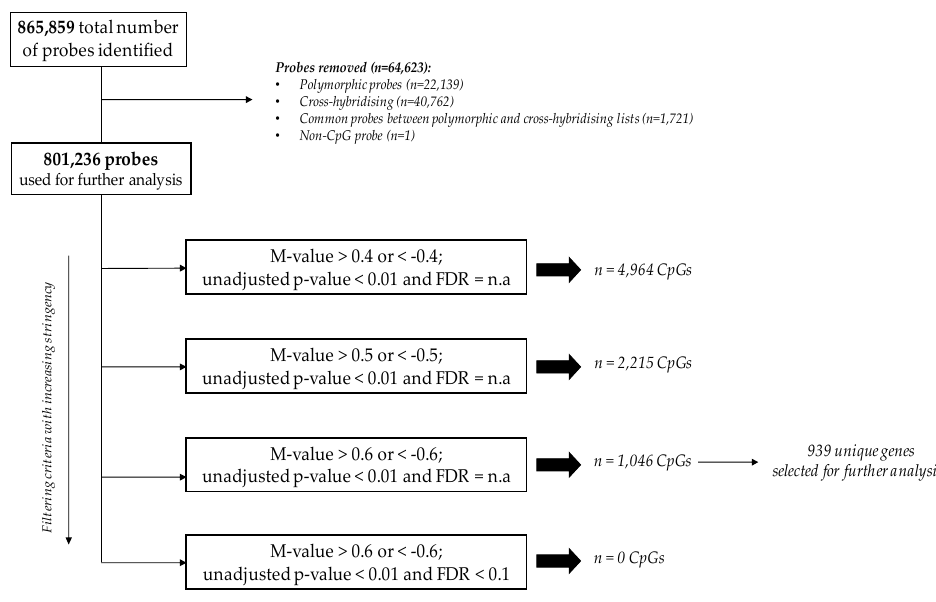
Figure 3. Filtering criteria for the identification of CpGs differentially methylated between GDM and non-GDM groups. A total of 801,236 probes, derived through the removal of polymorphic, cross-hybridising and non-CpG probes were used for analysis. FDR: false discovery rate; M-values closest to 0 indicate similar methylation intensities between probes.